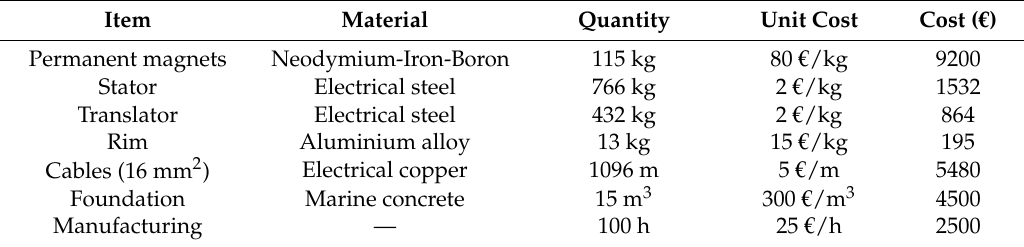
Table 4. Linear generator preliminary cost analysis.